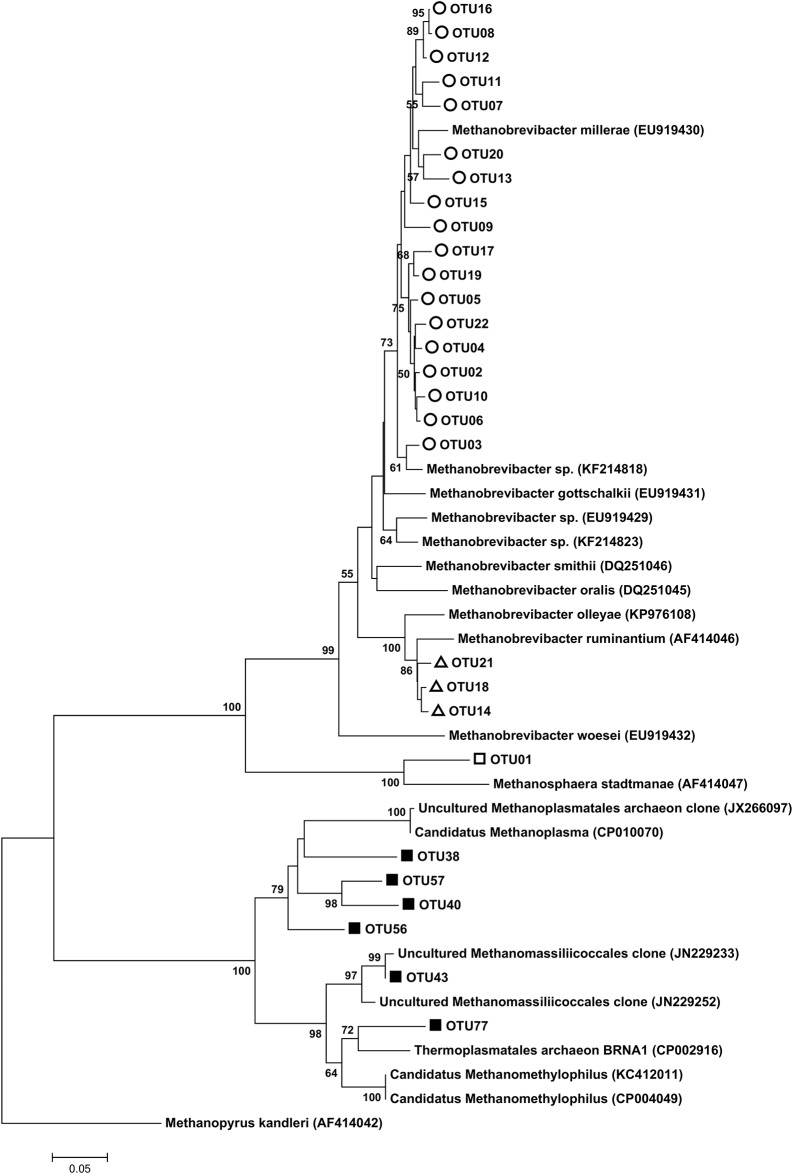
Phylogeny of the Methanobacteriales-related OTUs and Methanomassiliicoccales-related OTUs.Representative mcrA sequences from the most abundant Methanobacteriales-related OTUs (22 OTUs) and Methanomassiliicoccales-related OTUs (6 OTUs) were picked out for the construction of the phylogenetic tree, and reference mcrA gene sequences were downloaded from the NCBI nucleotide database. The tree was created using the Neighbor-joining method with 500 re-assemblies; bootstrap values greater than 50 are shown. Three Methanobacteriales clades are indicated by different symbols: the Methanosphaera clade (squares), the Methanobrevibacter ruminantium clade (triangles) and the Methanobrevibacter gottschalkii clade (circles). The Methanomassiliicoccales clade is indicated by filled squared.